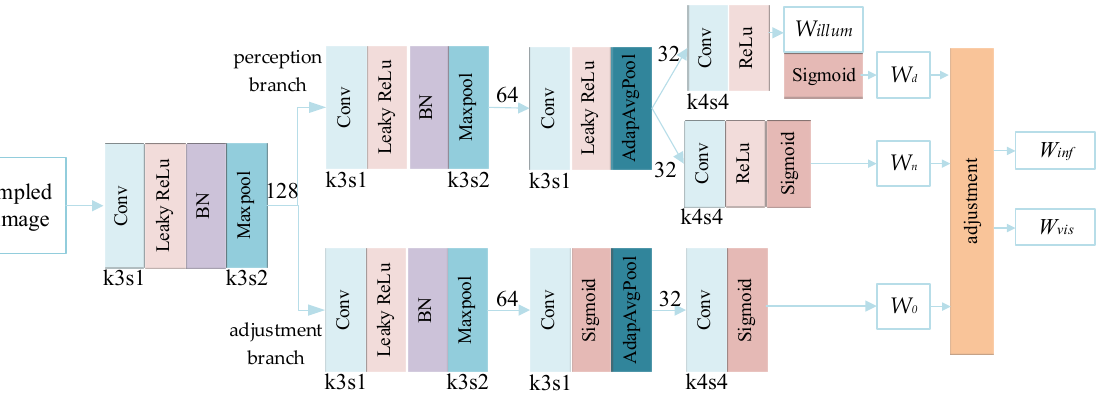
Figure 3. Interior structure of local illumination perception module. k3s1 indicates that the kernel size is 3 and stride is set to 1. The number on the connecting line represents the number of channels of the output feature map.